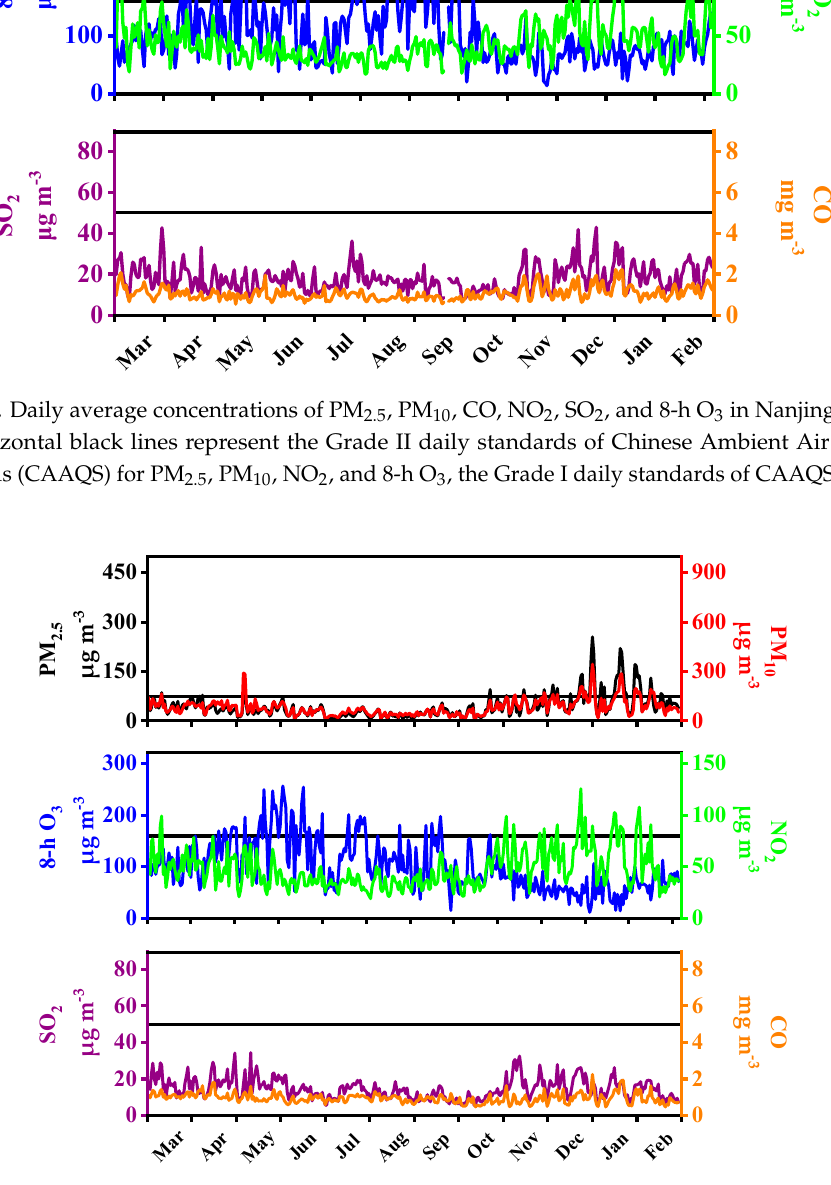
Figure 6. Daily average concentrations of PM 2.5 , PM 10 , CO, NO 2 , SO 2 , and 8-h O 3 in Nanjing in 2017. The horizontal black lines represent the Grade II daily standards of Chinese Ambient Air Quality Standards (CAAQS) for PM 2.5 , PM 10 , NO 2 , and 8-h O 3 , the Grade I daily standards of CAAQS for SO 2 and CO.